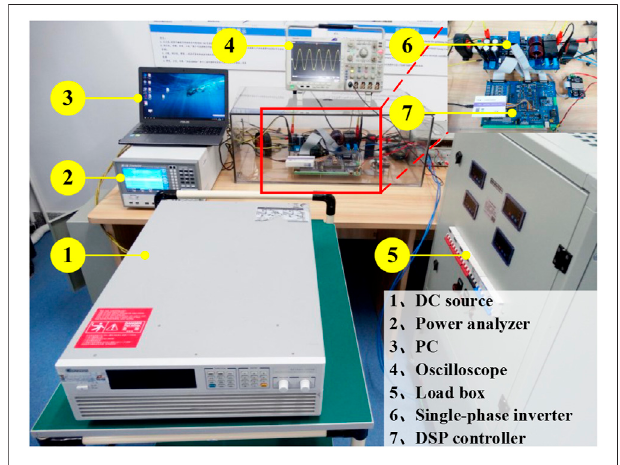
FIGURE 5 | CM voltage waveforms of the Si/SiC hybrid switch.